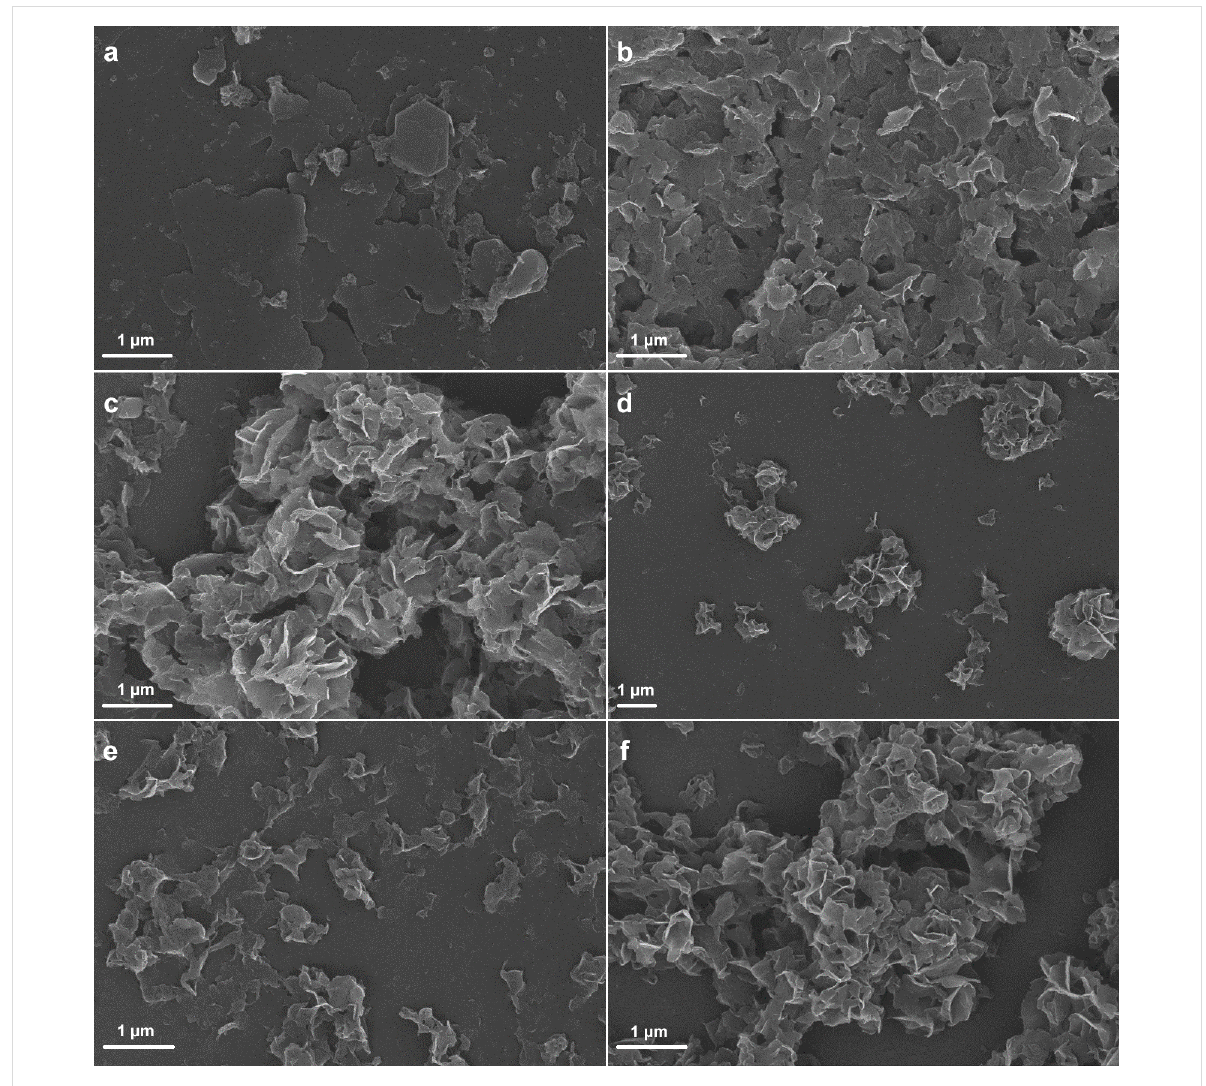
Figure 4: SEM images of (a) HALS-Ca 2 Al, (b) MP-Ca 2 Al and (c) H 2 M 1 -Ca 2 Al, (d) H 1 M 1 -Ca 2 Al, (e) H 1 M 2 -Ca 2 Al, (f) H 1 M 3 -Ca 2 Al.